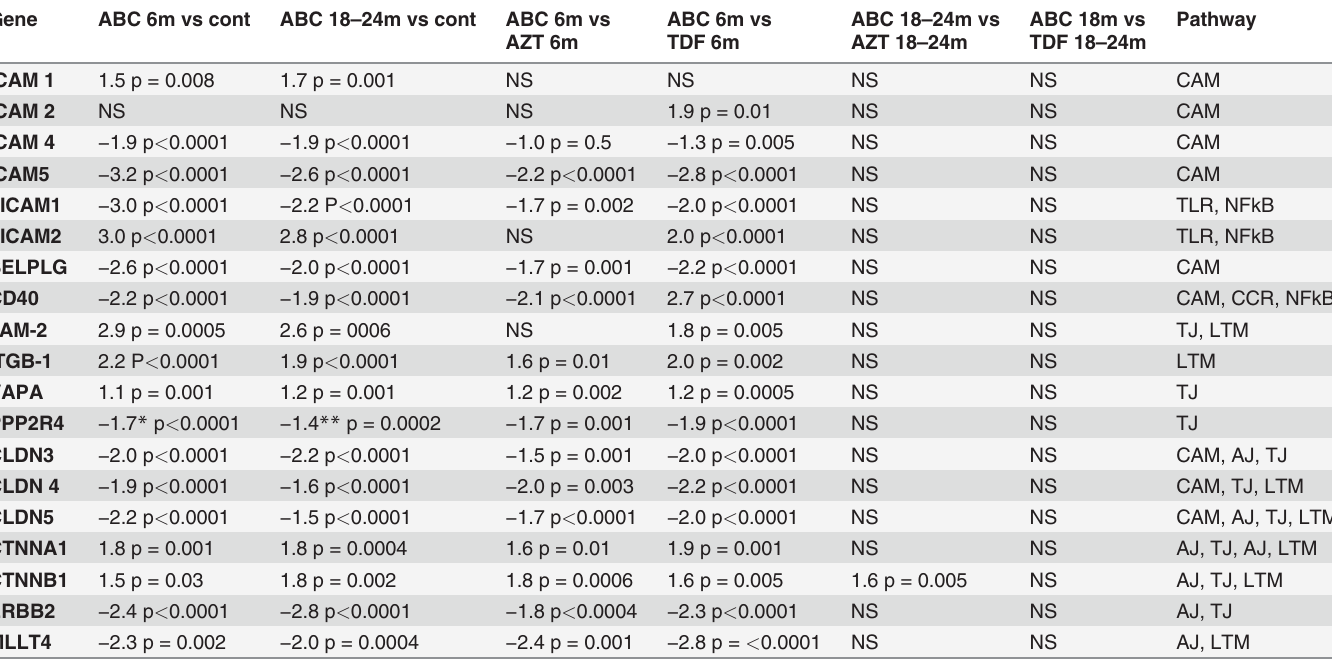
Table 5. Expression of selected genes involved with endothelial cell adhesion molecules, tight junction and adherence junction.